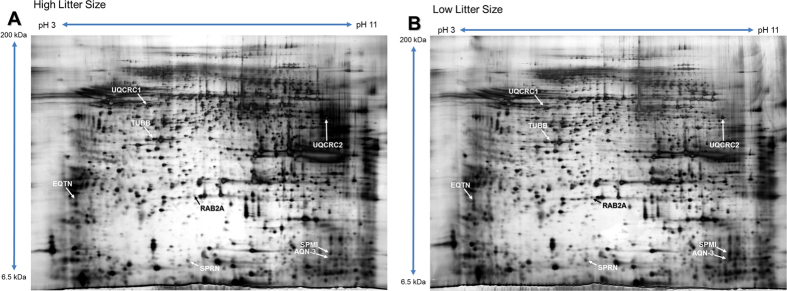
Separation of proteins with 2-DE.2-DE gels were stained with silver nitrate and analyzed using PDQuest 8.0 software. (A) Protein spots from high-litter size spermatozoa after capacitation. (B) Protein spots from low-litter size spermatozoa after capacitation.